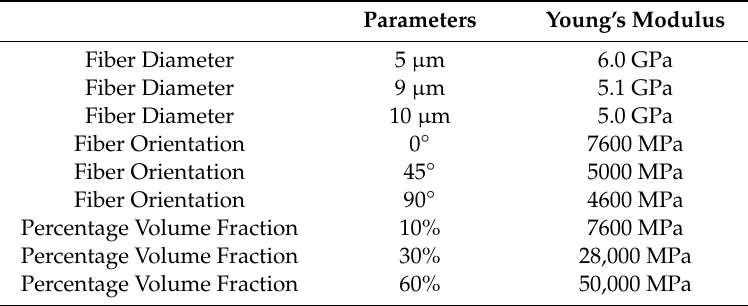
Table 1. 3D printed carbon PEEK material parameters [28].